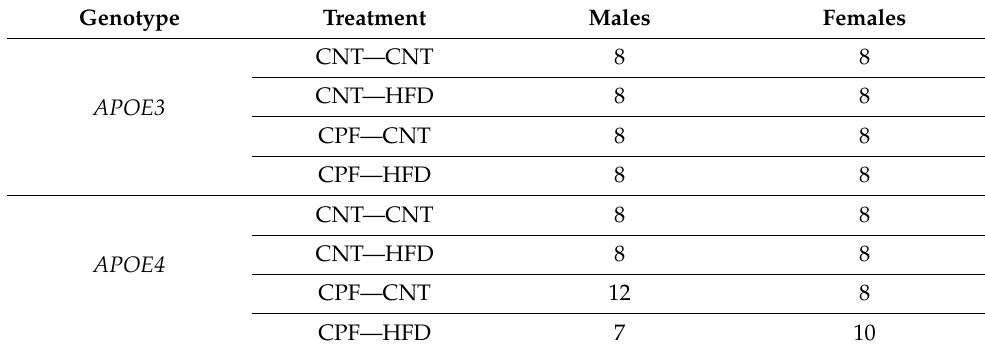
Table 3. Number of animals in each group in the high-fat diet (HFD) challenge. Genotype